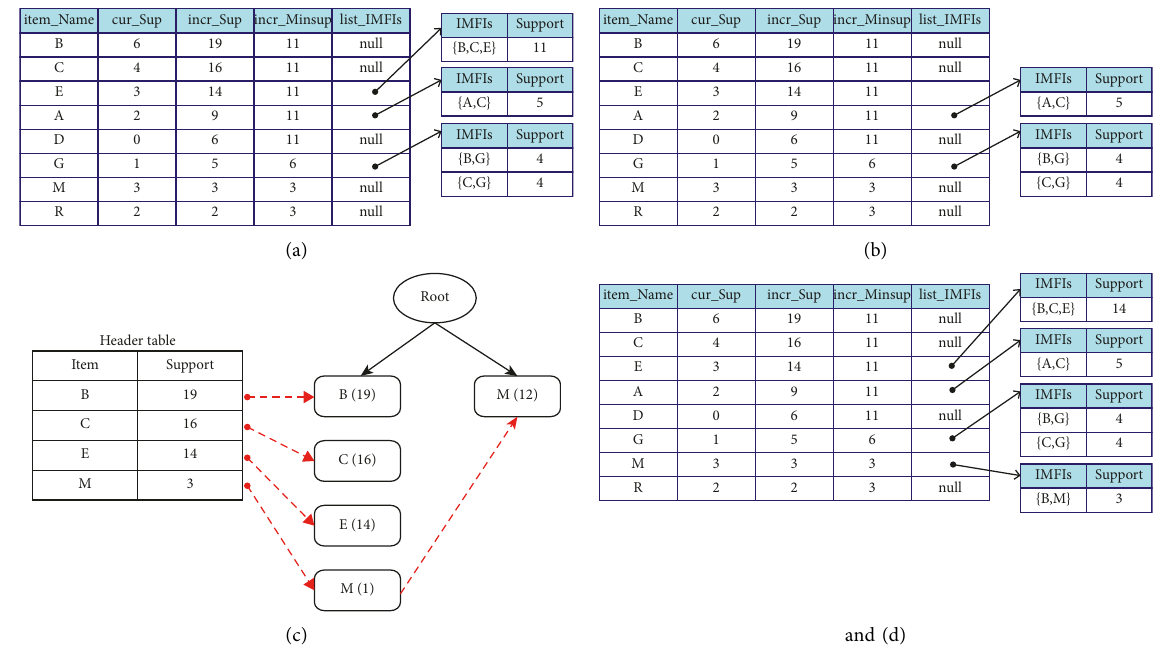
Figure 5: Example at T3. (a) P3 after Phase 1, (b) P3 after phase 2, (c) tree as FP-tree after phase 2, and (d) P3 after phases Table 12: Characteristics of experimental datasets. Table 10: Generated rules that have Conf 0.7 after phase 5 at T3. ≥